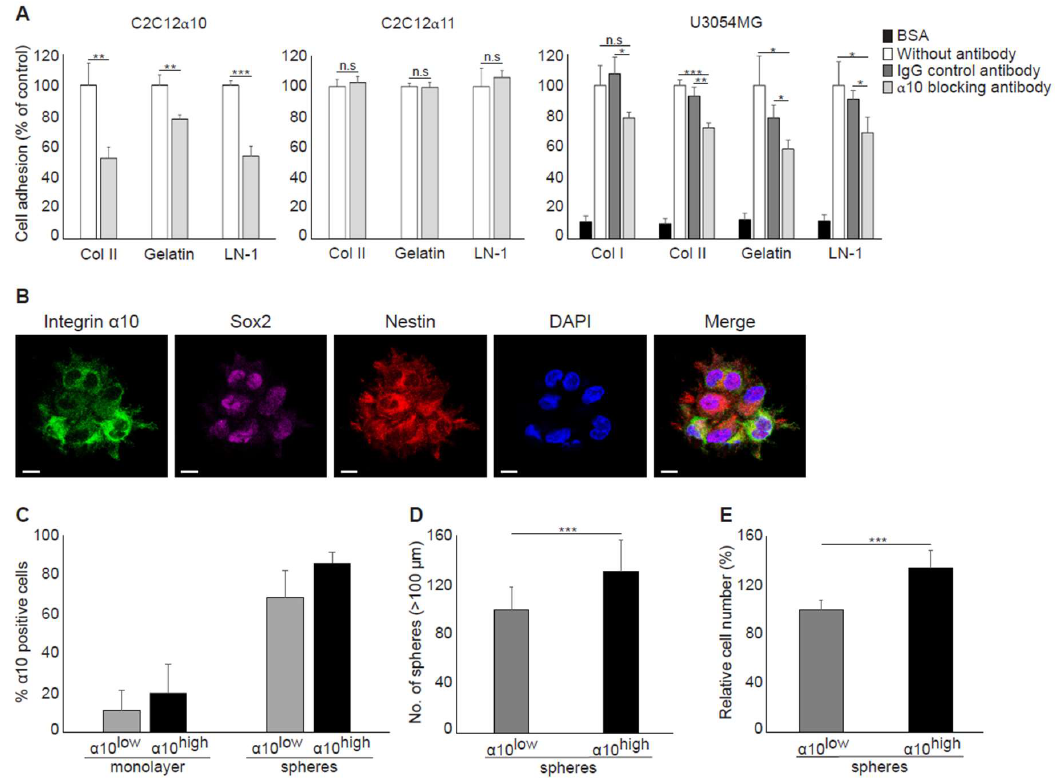
Figure 4. Integrin α10β1 mediates adhesion to collagen and laminin and promotes sphere formation and proliferation. ( A ) Adhesion of mouse myoblast cells C2C12 transduced with integrin α10 vector (C2C12α10) or integrin α11 vector (C2C12α11) and GBM U3054MG cells to dishes pre-coated with collagen I (Col I), collagen II (Col II), gelatin, or laminin-111 (LN-1) for 1 h in the absence or presence of an isotype control IgG2a antibody or a function-blocking monoclonal integrin α10 antibody. Bovine serum albumin (BSA)-coated wells were used as a negative and non-specific control. Adhered cells were quantified by crystal violet and spectrophotometric analysis. The bar graph shows percentage cell adhesion compared with non-treated control cells. Data are one representative experiment, and error bars show the SD in triplicates. Statistically significant differences were determined by unpaired two-tailed Student’s t -test, where * p ˂ 0.05; ** p ˂ 0.01; *** p ˂ 0.001. n.s.: not significant. ( B ) Unsorted U3054MG cells cultured as spheres. Triple immunofluorescence labeling of integrin α10 protein, Sox2 and Nestin, DAPI staining of cell nuclei, and a merged image (Merge). Scale bars represent 10 µm. ( C ) The number of integrin α10-positive cells measured by flow cytometry of α10 high - and α10 low - sorted U3054MG cells grown in monolayer or as spheres. Data are presented as the mean from three independent experiments. ( D ) Sphere formation capacity of α10 high -and α10 low -cells measured after 7 days of culturing. Microscopy images of each well were taken and spheres that had reached a diameter of more than 100 µm were counted using ImageJ software. Data are presented as the mean from five independent experiments. ( E ) Cell proliferation of α10 high - and α10 low - cells after 4‒5 days of culturing as spheres was determined by using the WST-1 cell proliferation assay. Data are presented as the mean from four independent experiments. The number of spheres and relative cell number is normalized against α10 low -cells. Error bars show the SD, and the unpaired two-tailed Student’s t -test was performed, where * p ˂ 0.05; ** p ˂ 0.01; *** p ˂ 0.001. 2.4.2. Integrin α10β1 Promotes Proliferation of GBM Cells and Sphere Formation When we examined integrin α10 expression levels in spheres by immunofluorescence, we found that all cells express α10 but at different levels. Moreover, we also found partial cellular co-expression of integrin α10β1 with both Sox2 and Nestin in the spheres (Figure 4B). We then sorted U3054MG cells into integrin α10 high and α10 low populations and cultured the cells as spheres or in a monolayer